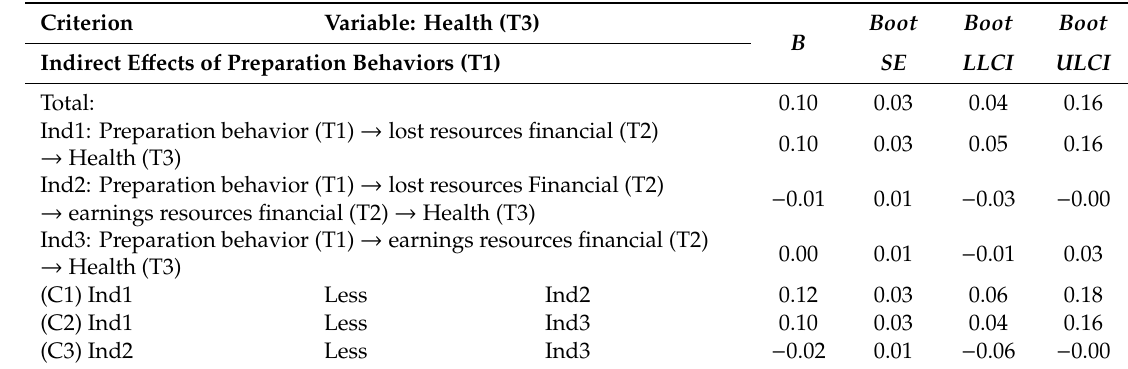
Table 11. Comparison of the indirect effects of preparation behaviors (T1) through financial resource losses (T2) and gains (T2) in the prediction of health (T3).